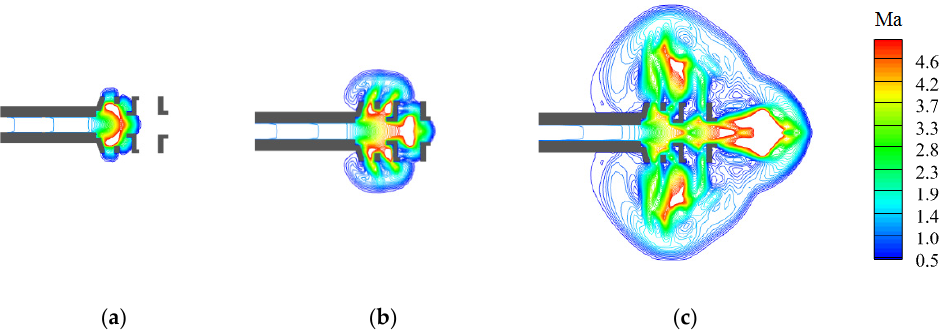
Figure 17. Distribution of Mach number in muzzle brake of type 1. ( a ) t = 0.05 ms. ( b ) t = 0.10 ms. ( c ) t = 0.20 ms.